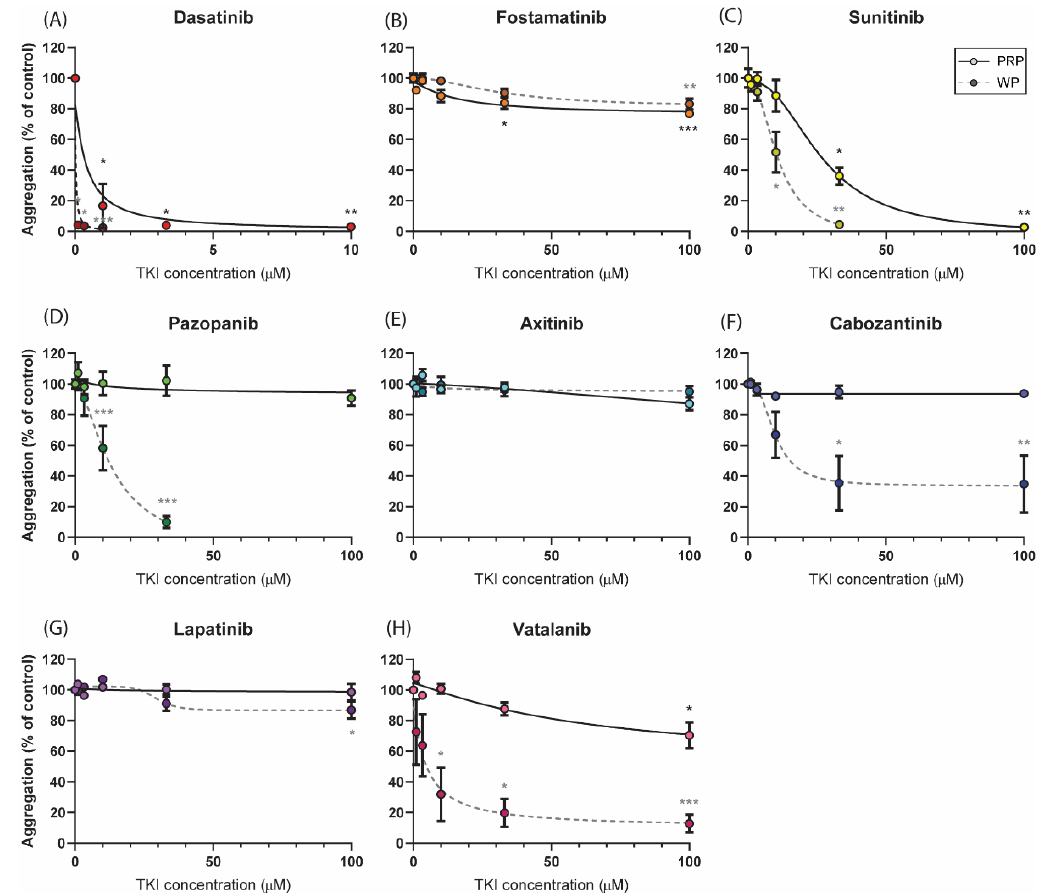
Figure 2. Dose-dependent effects of TKIs on platelet aggregation induced by collagen. Washed platelets or PRP (250 × 10 9 /L) were incubated with the vehicle (<0.1% DMSO) or TKI for 10 min. Dose–response curves of the inhibition of aggregation induced by collagen Type I (1 µ g/mL) are shown for ( A ) dasatinib, ( B ) fostamatinib, ( C ) sunitinib, ( D ) pazopanib, ( E ) axitinib, ( F ) cabozantinib, ( G ) lapatinib, or ( H ) vatalanib, measured in either PRP (solid line) or washed platelets (dotted line). Maximum aggregation responses were determined at 8 min; data are shown as means ± SEM ( n = 6). * p < 0.05, ** p < 0.01, and *** p <